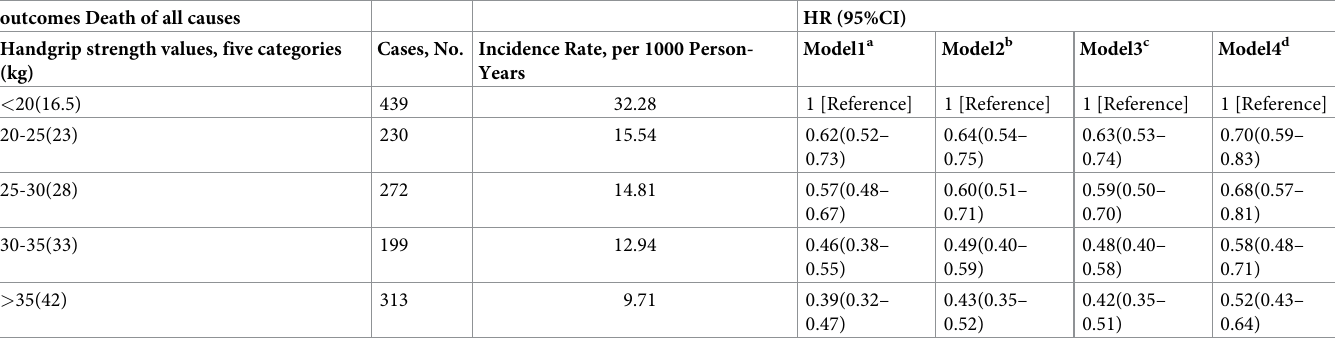
Association of handgrip strength and death risk stratified by covariates Fig 3 shows the association between handgrip strength and death risks stratified by potential risk factors. There is no evidence for interaction between handgrip strength and death event of different factors. The results did not significantly change after adjusting for sex, age, registra- tion, marriage, education, income, drinking/smoking status, BMI, falls, hypertension, diabetes, chronic lung disease, heart disease, and stroke. Similar patterns were found when analyses were repeated on original data as sensitivity test. Table 2. Incidence of death of all causes according to the handgrip strength